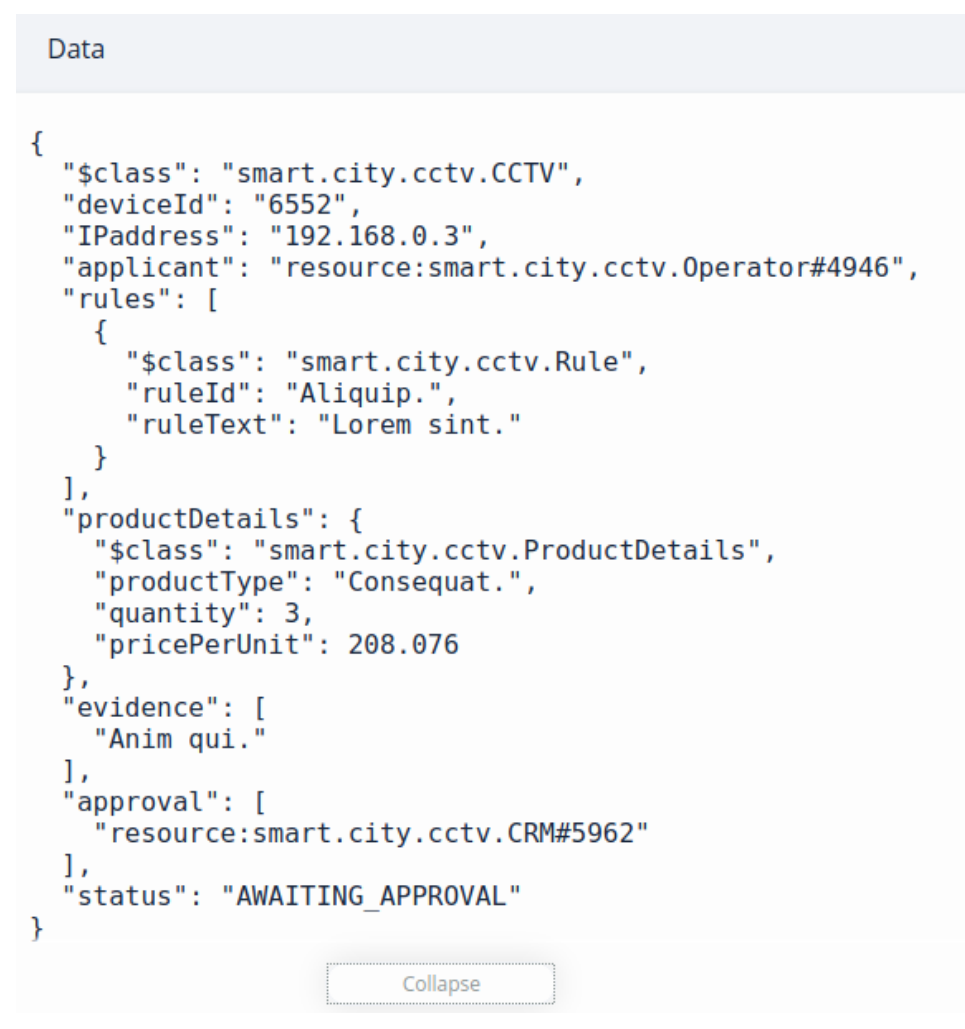
Figure 8. Meta Data for a CCTV